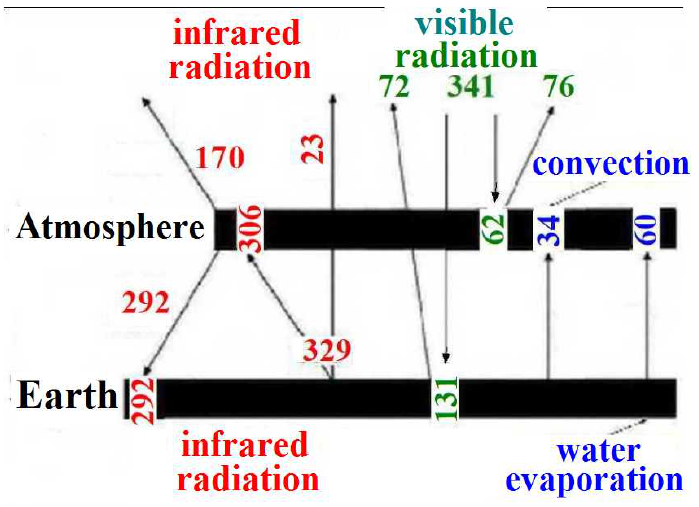
Figure 7. Energetic balance of the Earth and atmosphere for the cold period of the glacial cycle. The presented average energy fluxes are expressed in W/m 2 for these processes. Absorbed energy fluxes are given inside the corresponding rectangles, and the values of energy fluxes themselves are given near the